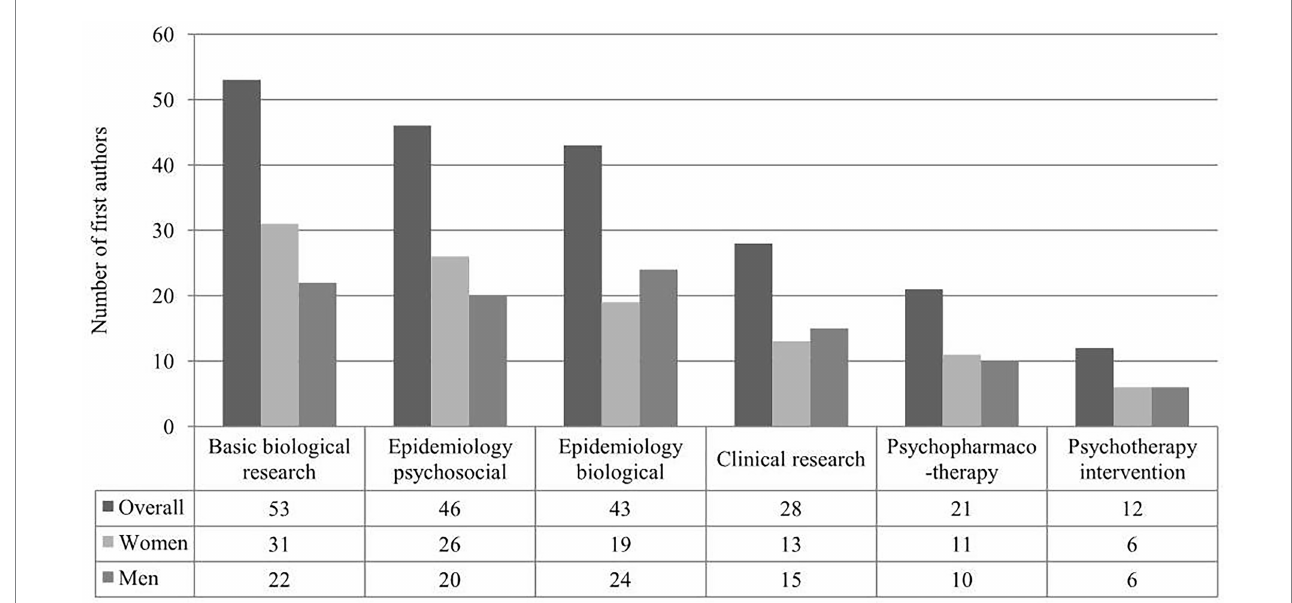
FIGURE 2 Number of female and male first authors of original research articles ( n = 234) by subject matter (illustration of the six highest ranked) in 2019.